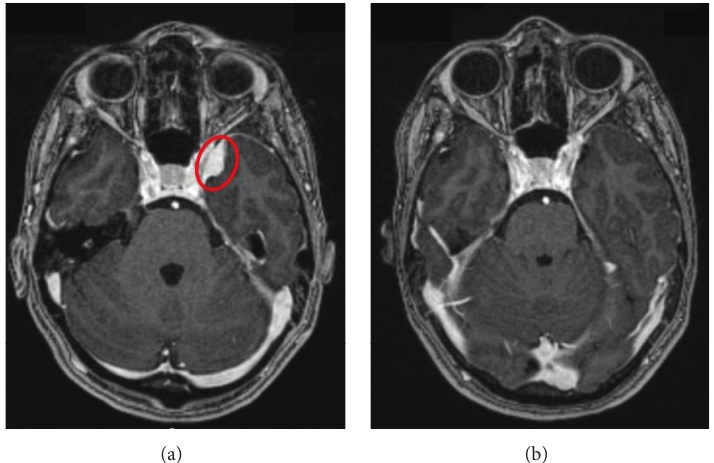
Figure 2: MRI illustrating the patient’s meningioma (red): (a) 9 days before induction and (b) 8 months